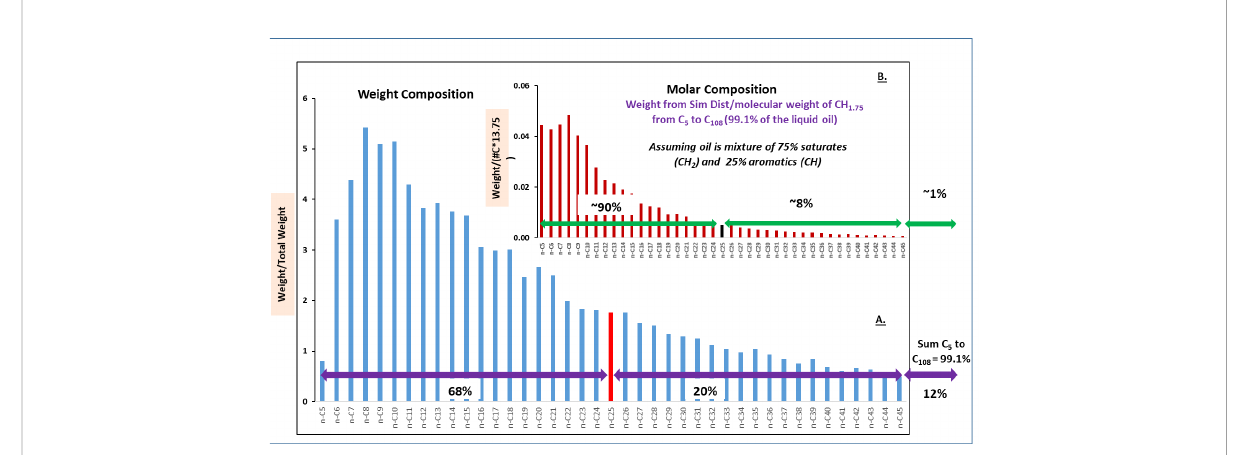
FIGURE 3 Plots of the results from the simulated distillation of the Macondo oil separated by carbon number and expressed as the weight percent (blue bars, (A) and molar percent (red bars, (B) . The molar fractions were calculated assuming that the molecular weight of each carbon number fraction was estimated from the carbon number multiplied by 13.75 (assuming average CH 1.75 molar ratio based on C and H percent composition in the Macondo crude). Ninety percent of molecules in the initially spilled liquid Macondo oil were contained in the fractions with carbon numbers (86.6% C and 12.6% H) less than C 25 , while this fraction accounted for 68% of the liquid oil ’ s initial mass. (Modi fi ed from Aeppli et al., 2018 with